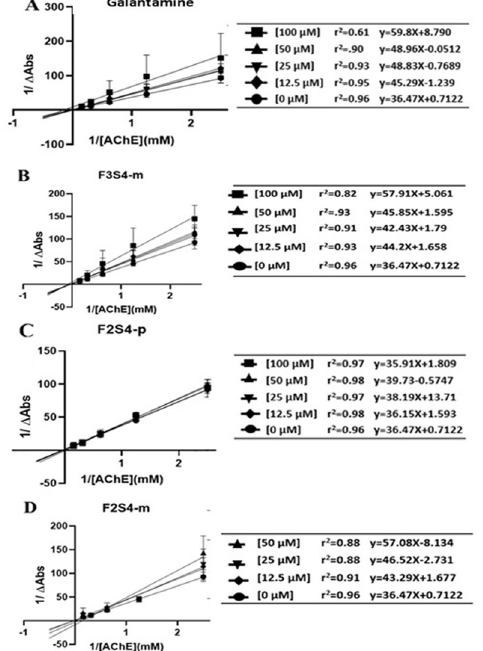
Fig 6. Lineweaver-Burk kinetic model of AChE inhibition by A) Galantamine, B) F3S4-m, C) F2S4-p and D) F2S4-m.